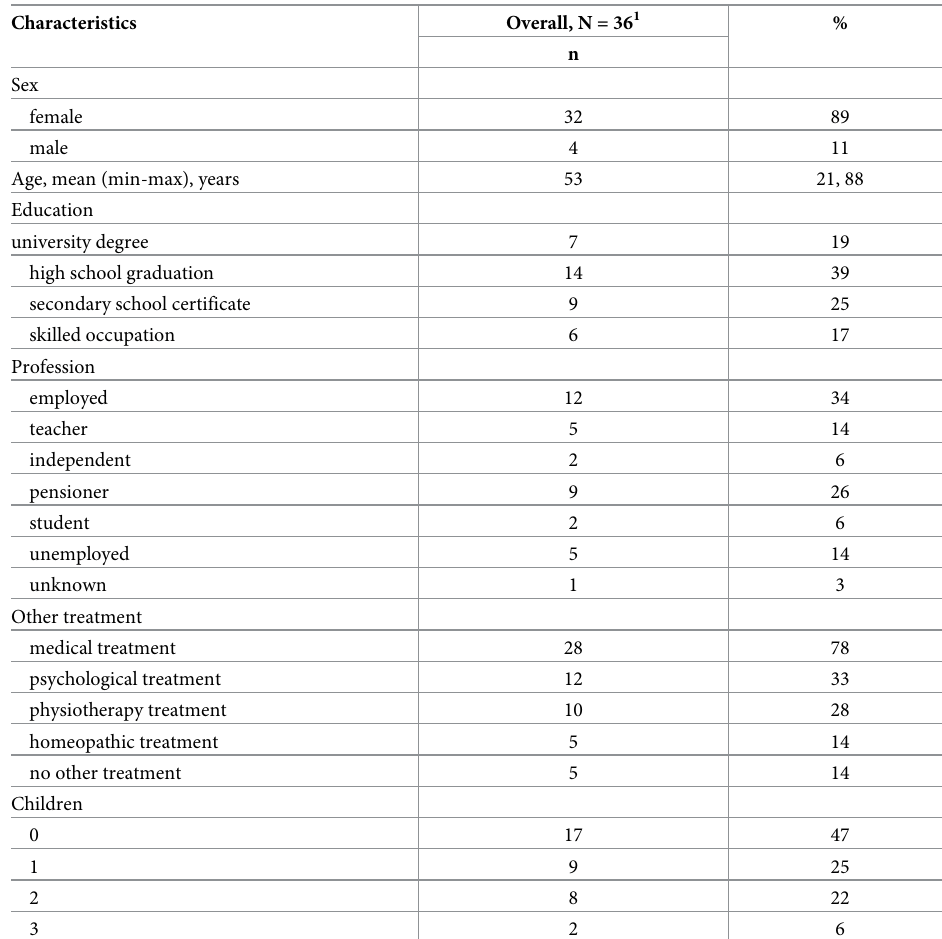
Table 1. Sample description of participants.